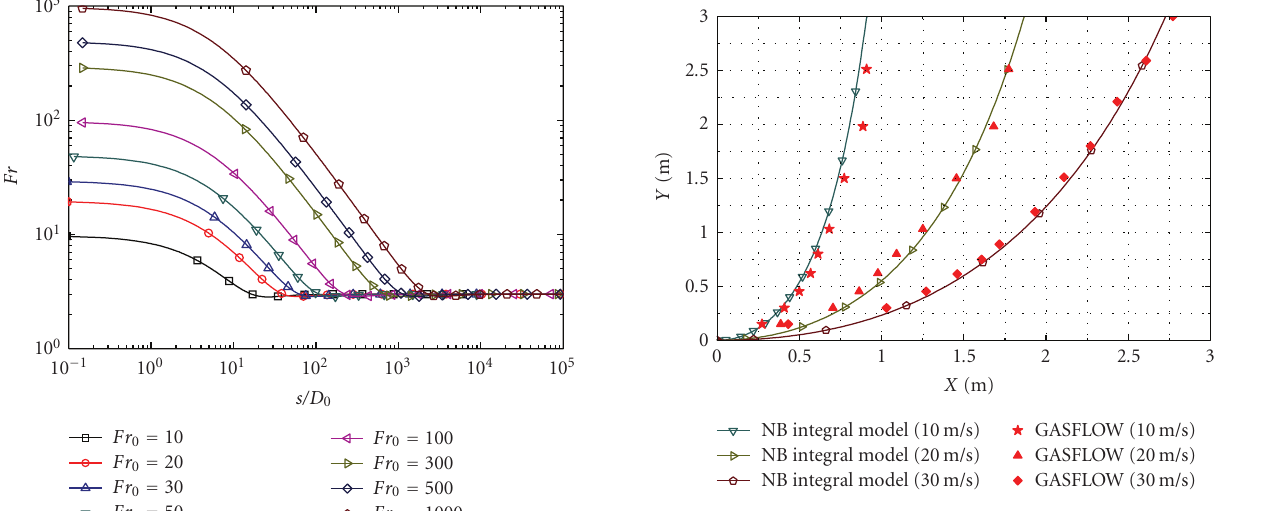
Figure 7: Froude number decay of horizontal buoyant jet.